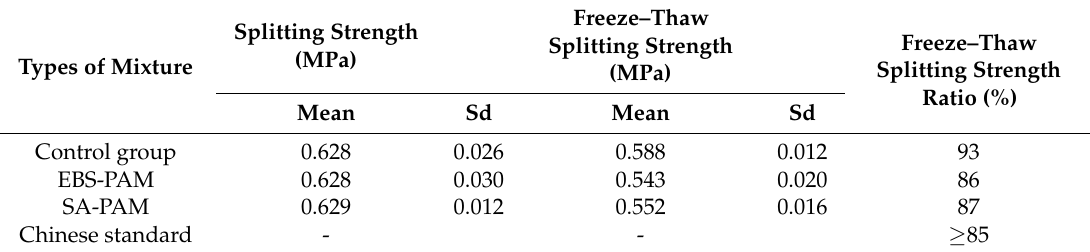
Table 7. The results of the freeze–thaw splitting test.